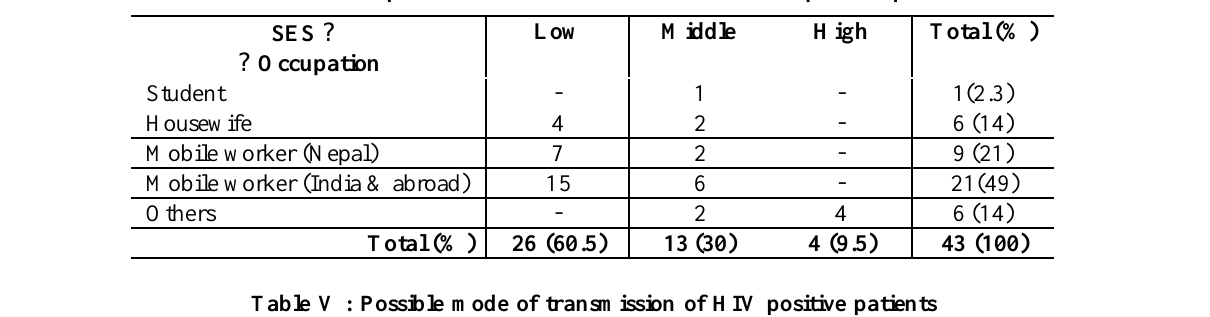
Table IV : Occupation & socio-economic status of HIV positive patients